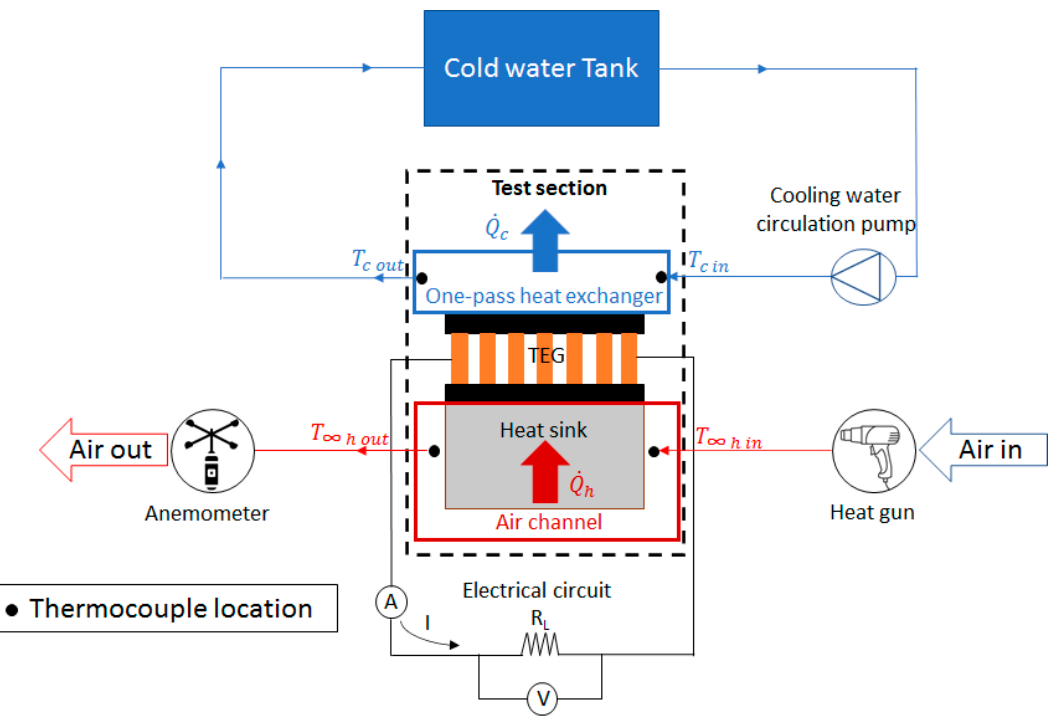
Figure 4. Schematic diagram of the experimental setup.